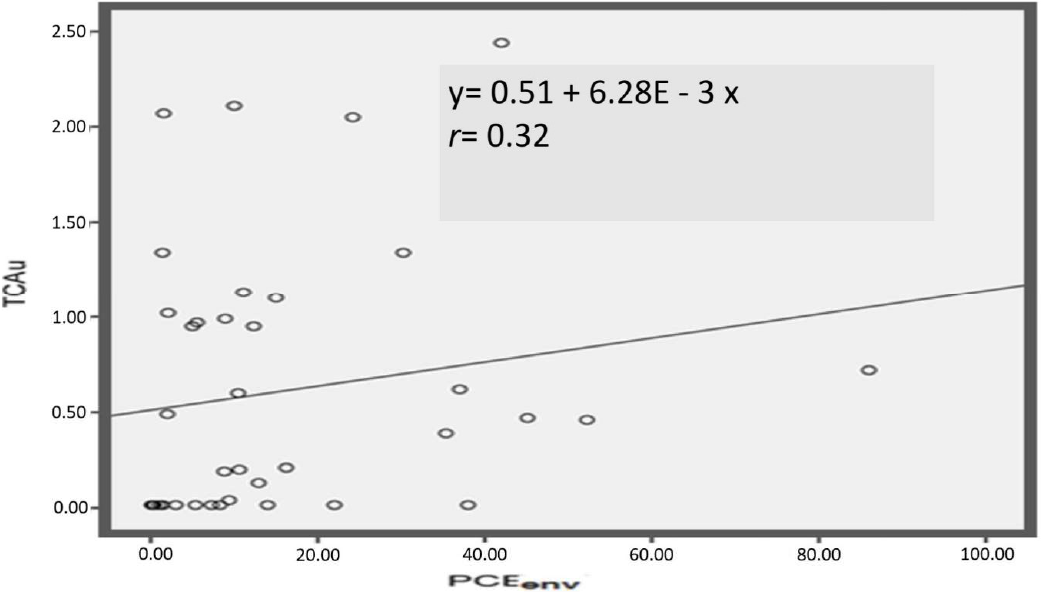
Figure 4. Correlation between PCE concentration in the proximity of workers’ airways (PCE env ) and TCA concentration in the workers’ urines at the end of the work shift (TCA u ). The regression line equation and the Spearman r coefficient are also reported.